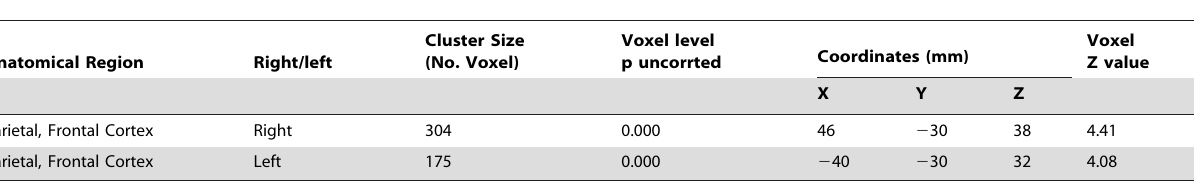
Table 2. Group Comparison of Increased Fractional Anisotropy (FA) in White Matter.